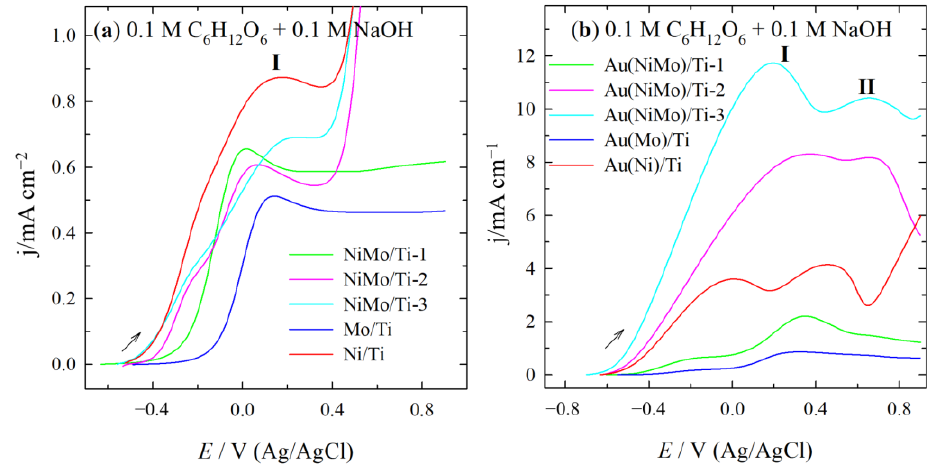
Figure 7. Positive-going potential scans (1 st cycles) of: ( a ) Ni/Ti, Mo/Ti, NiMo/Ti-1, NiMo/Ti-2, and NiMo/Ti-3; ( b ) Au(Ni)/Ti, Au(Mo)/Ti, Au(NiMo)/Ti-1, Au(NiMo)/Ti-2, and Au(NiMo)/Ti-3 catalysts in 0.1 M C 6 H 12 O 6 + 0.1 M NaOH at 25 °C at an electrode potential scan rate of 50 mV s − 1 .